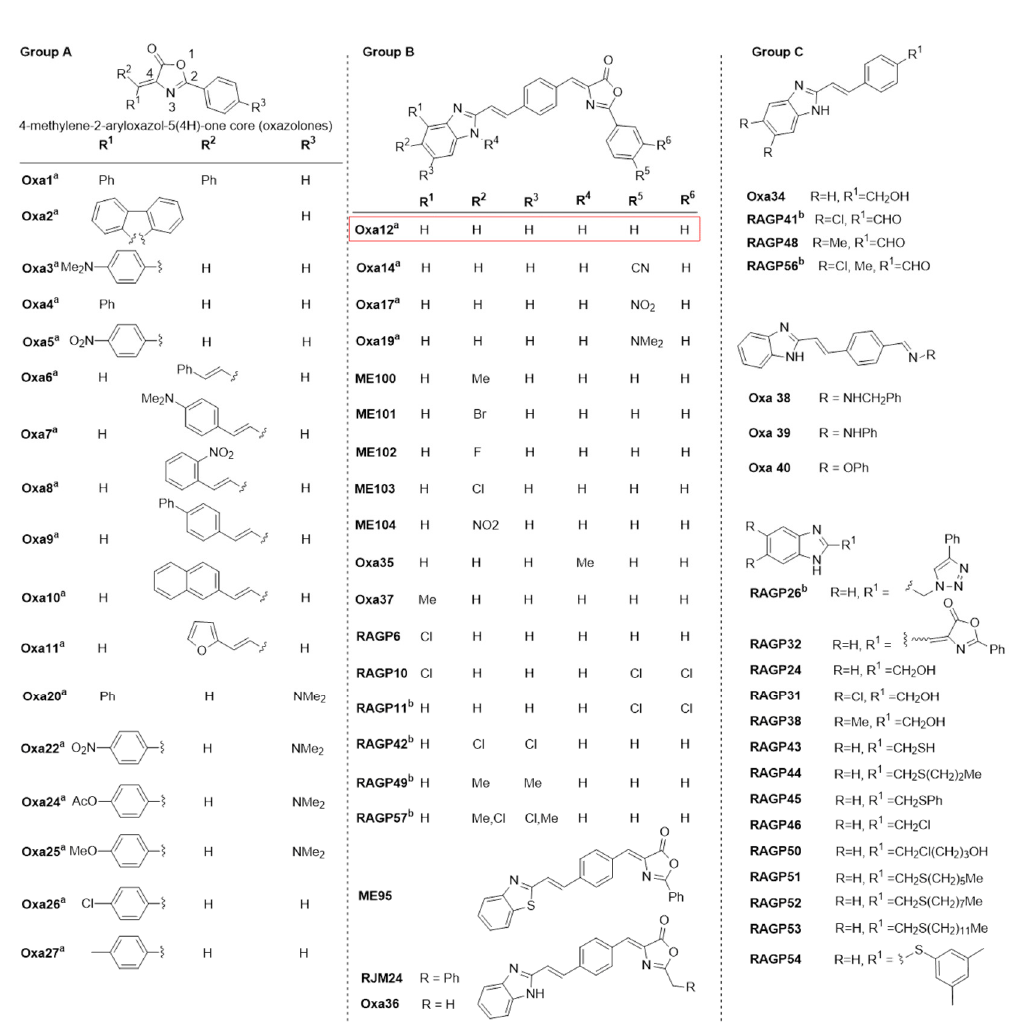
Figure 2. Structures of the synthesized small-molecule library compounds based on the 4-methylene-2-aryloxazol-5(4H)-one core (oxazolones). Group A includes oxazolones containing substituted aryl and aromatic heterocyclic attached to the 4-methylene position. Group B consists of extended oxazolones containing terminal fused heterocycles. Group C includes additional compounds without the oxazolone core or the 4-methylene side chain. a Synthesized compounds evaluated in a previous paper [22]. b Compounds not evaluated due to insoluble properties at the tested concentration.